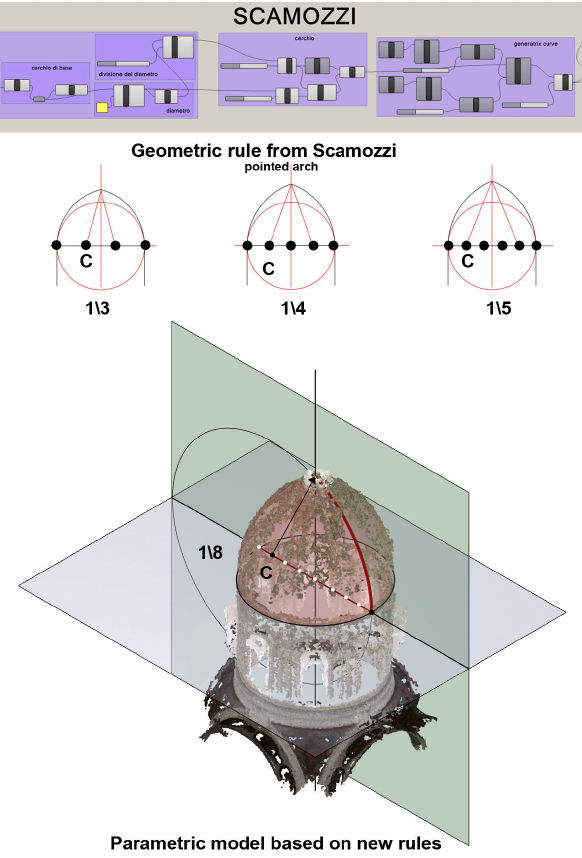
Figure 14. Design of new Parametric Shape Grammar Element